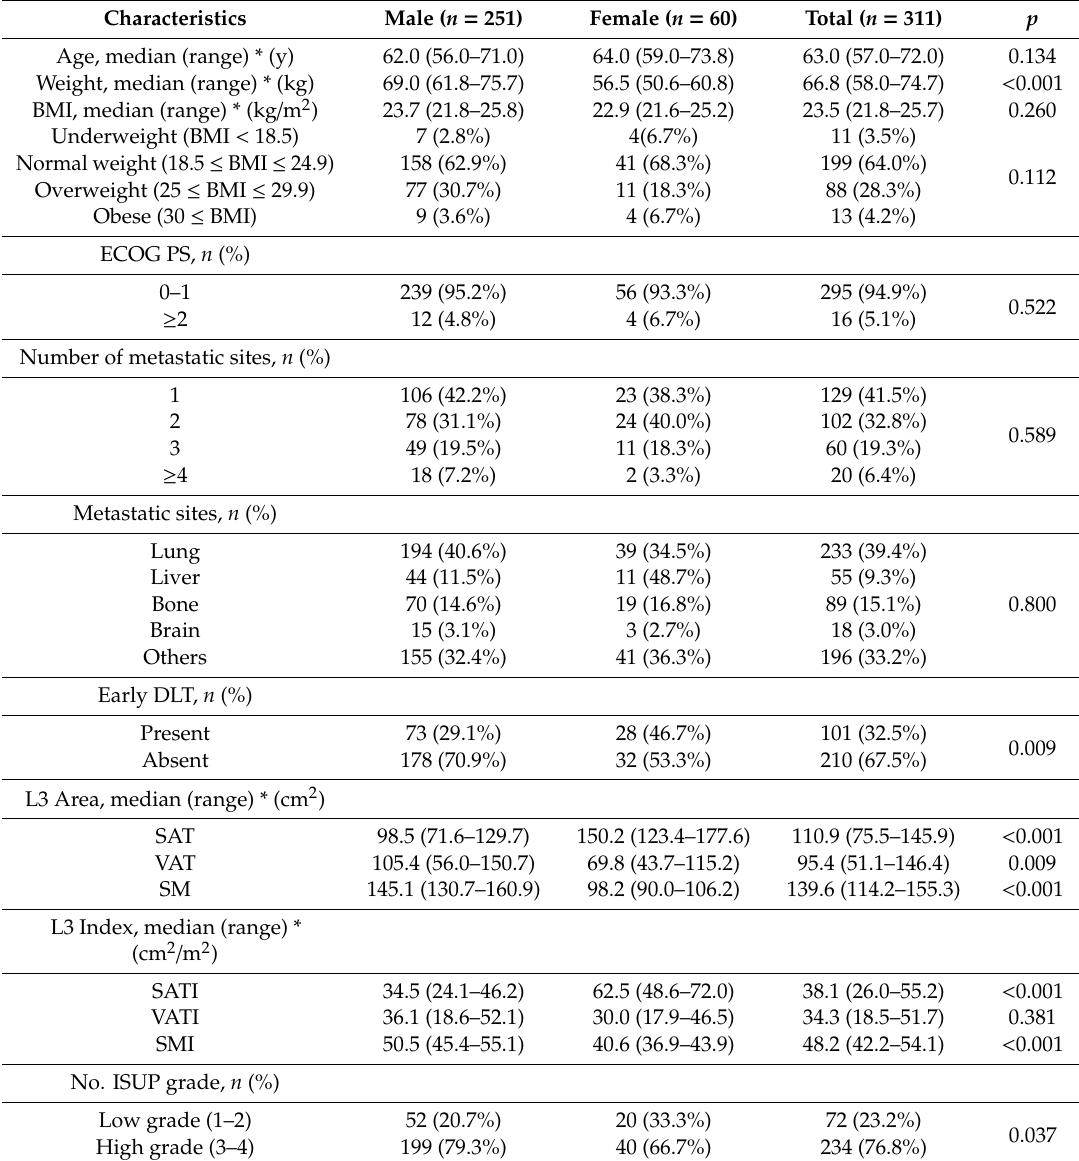
Table 1. Baseline characteristics of the patients treated with